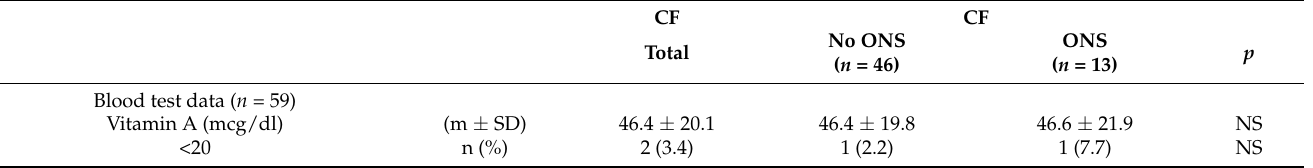
Table 4. Laboratory data. Association between blood test values and ONS